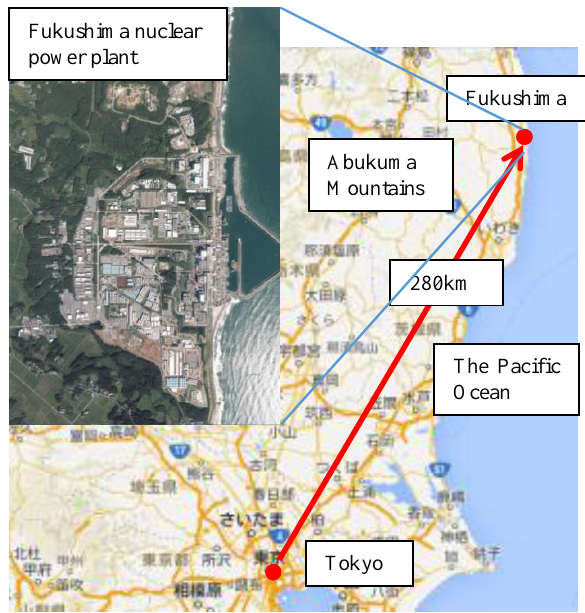
Figure 1. Location of Fukushima nuclear power plant